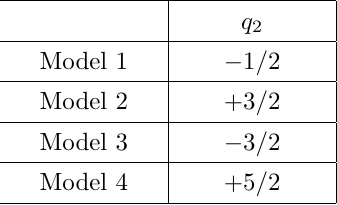
Table 2 . The charge assignments of H 2 for each